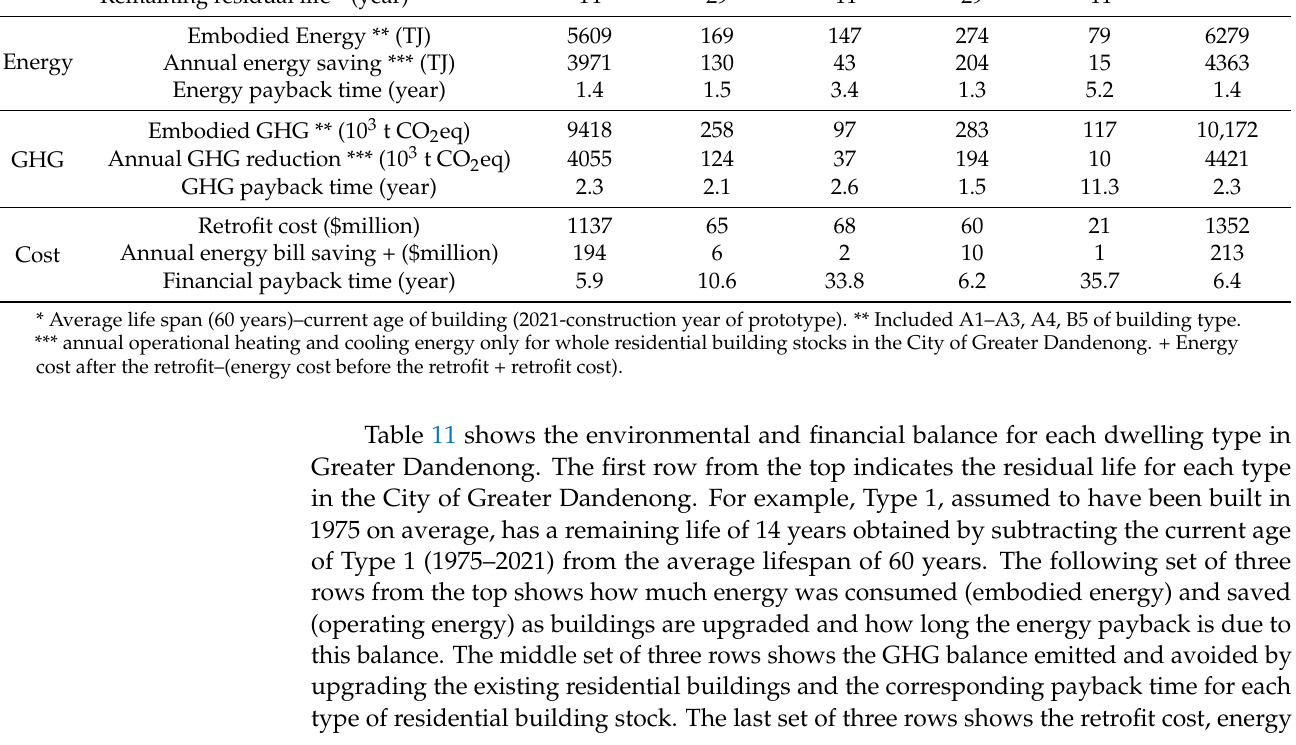
Table 11. Energy, GHG emissions and financial payback time considering the whole residential building stock in the City of Greater Dandenong. Residential Building Stocks in City of Greater Dandenong by Type Sum Type 1 Type 2 Type 3 Type 4 Type